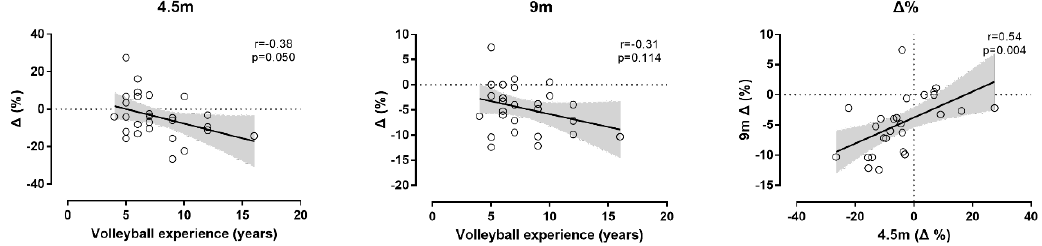
Figure 6. Relationship of percentage change ( ∆ %) from pre-test to post-test between sprint ability and volleyball experience.